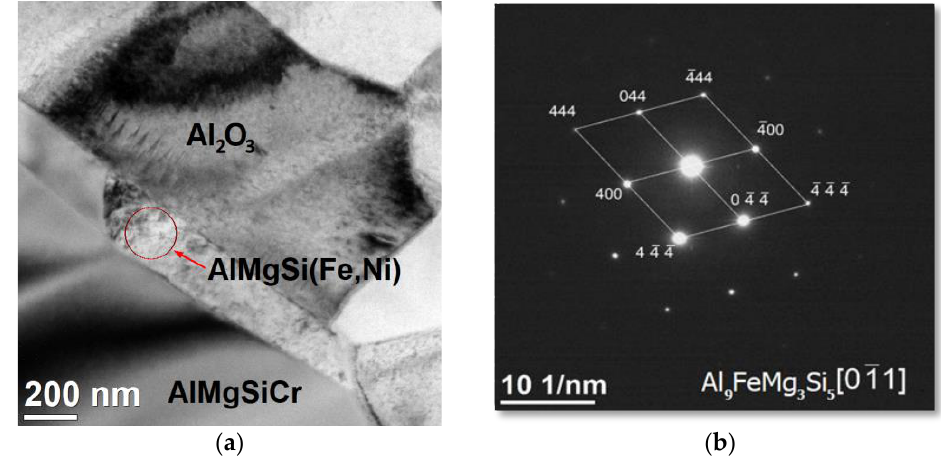
Figure 13. TEM image of the structure of a composite material produced by sintering a ceramic phase at 1600 °C, infiltrated at a pressure of 3 MPa ( a ). The SAED electron diffraction of the precipitation was taken from the area indicated by the arrow ( b ).